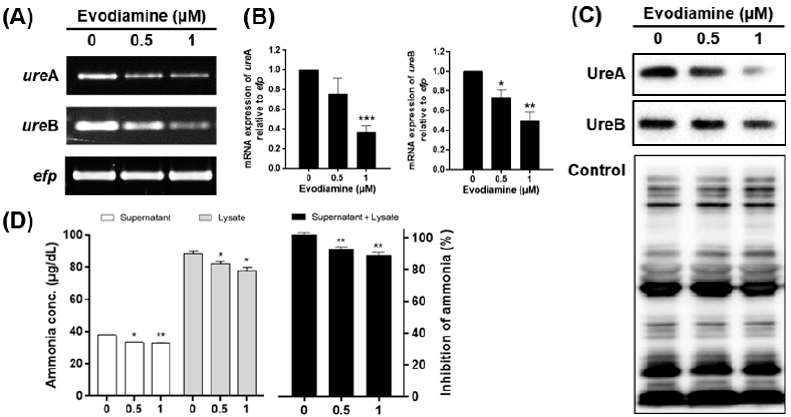
Figure 2. The inhibitory effects of evodiamine on the expression and activity of urease in H. pylori . ( A ) H. pylori was treated with indicated concentrations of evodiamine (0.5 and 1 μ M) for 72 h. RNA was subjected to RT-PCR to detect the mRNA expression levels of urease subunits ( ure A and ure B). The expression of efp was used as an internal control. ( B ) Each band intensity was normalized using to efp . ( C ) The cell lysates were subjected to Western blot to detect UreA and UreB. The rabbit anti- H. pylori polyclonal antibody was used as an internal control. ( D ) After 72 h, the supernatant and cell lysate were collected and then urease activity was determined by measuring ammonia levels. Each band intensity was normalized by protein quantification. Data were presented as mean ± SEM of three independent experiments and analyzed by Student’s t -test (* p < 0.05, ** p < 0.01 and *** p < 0.001).